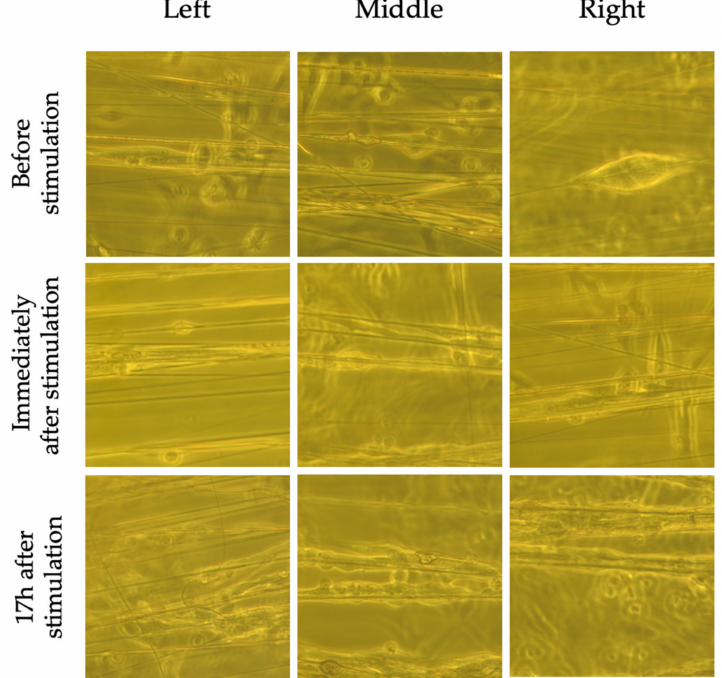
Figure 8. Bright field images of non-stimulated SH-SY5Y cells on aligned fibers before, immediately following and 17 h after ES. Cells near the electrode (left and right side as per Figure 3) do not appear to have changes in morphology or